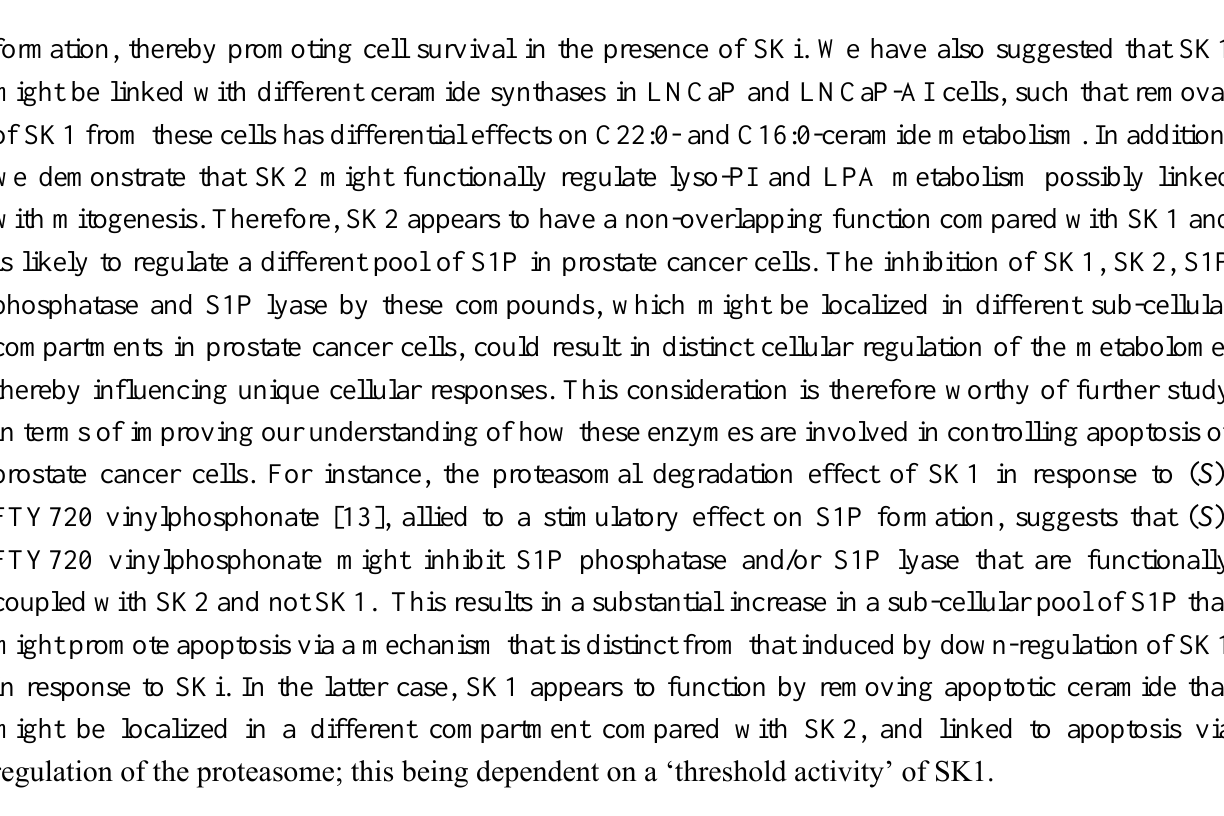
Table 5. Summary of effects of SKi, ( S )-FTY720 vinylphosphonate, and ( R )-FTY720 methyl ether (ROME) on prostate cancer